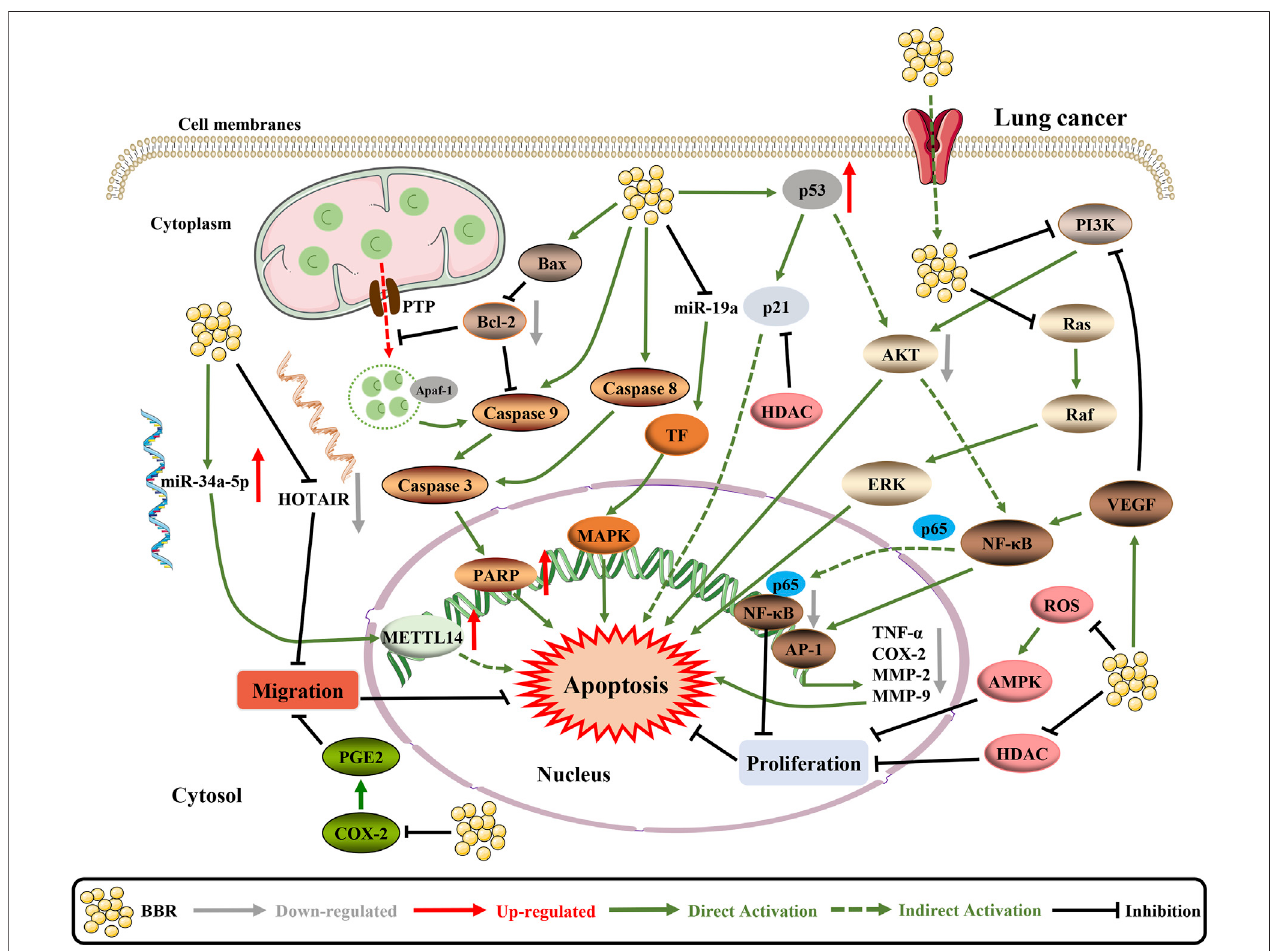
FIGURE5| Thepro-apoptoticmechanismsofBBRinlungcancer.BBRincreasestheactivityoftheBcl-2/BaxsignalingpathwayandinhibitstheVEGF/NF- κ B/AP- 1 signaling pathway to enhance cell apoptosis (Li et al., 2018b). BBR upregulates tumor suppressor genes (p21 and p53) mRNA and protein by inhibiting HDAC (Kalaiarasi et al., 2016). On the top of this, BBR can regulate the expression and interaction of HOTAIR and miR-34a-5p in human lung cancer cells, which signi fi cantly inhibitsEMTandinducesapoptosis(Zhengetal.,2020).Inaddition,BBRinhibitsthecellproliferationbytargetingPI3K/AKTandROS/AMPKsignalingpathwaysto activate apoptosis (Fu et al., 2013; Bhattacharyya et al., 2017).